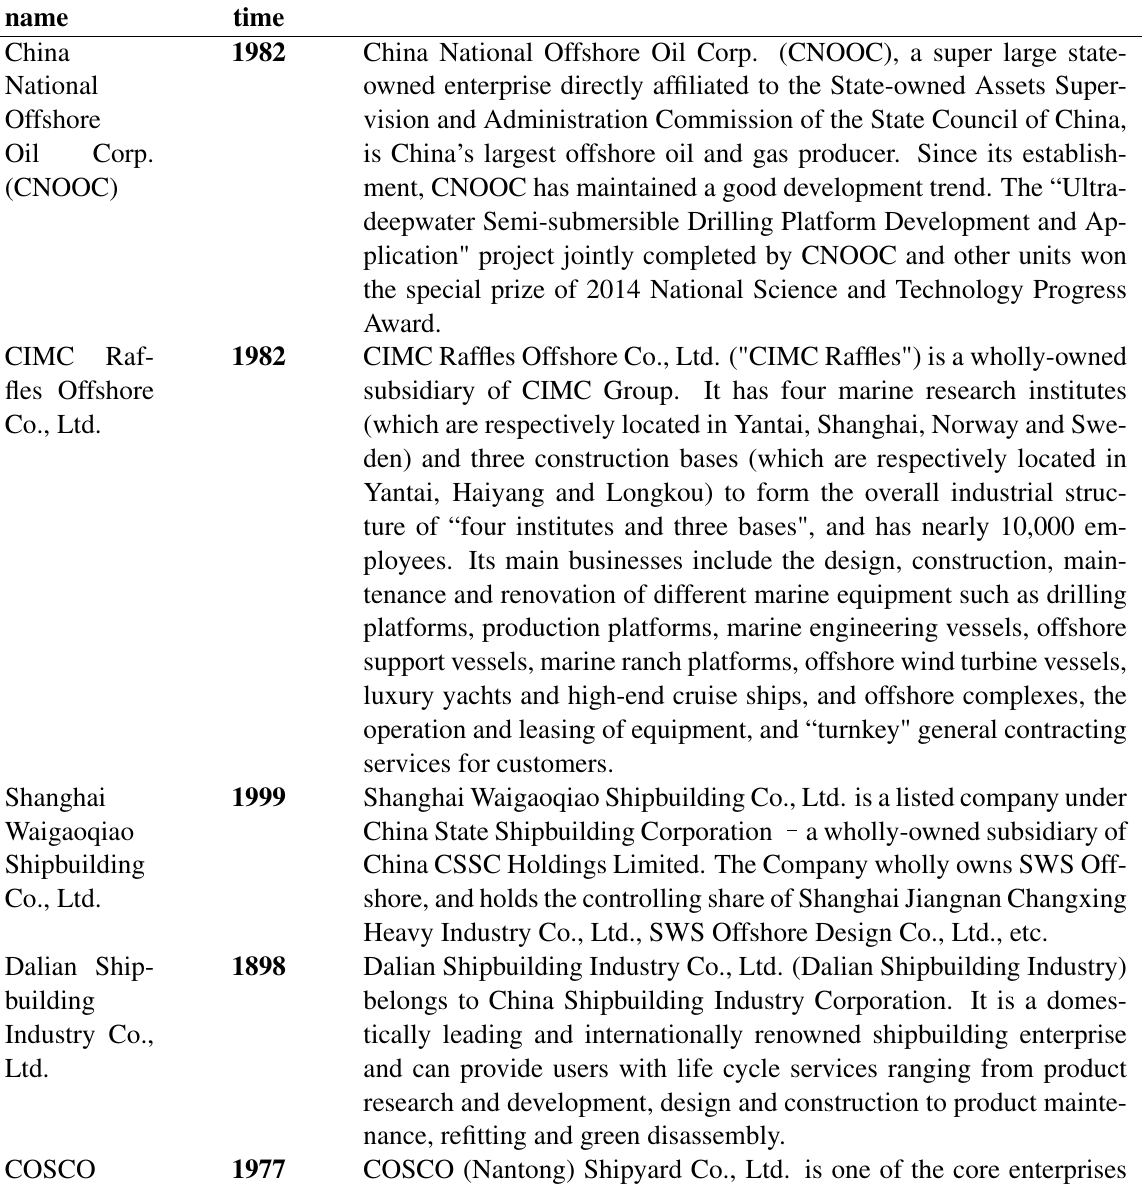
Table 1: Basic sample